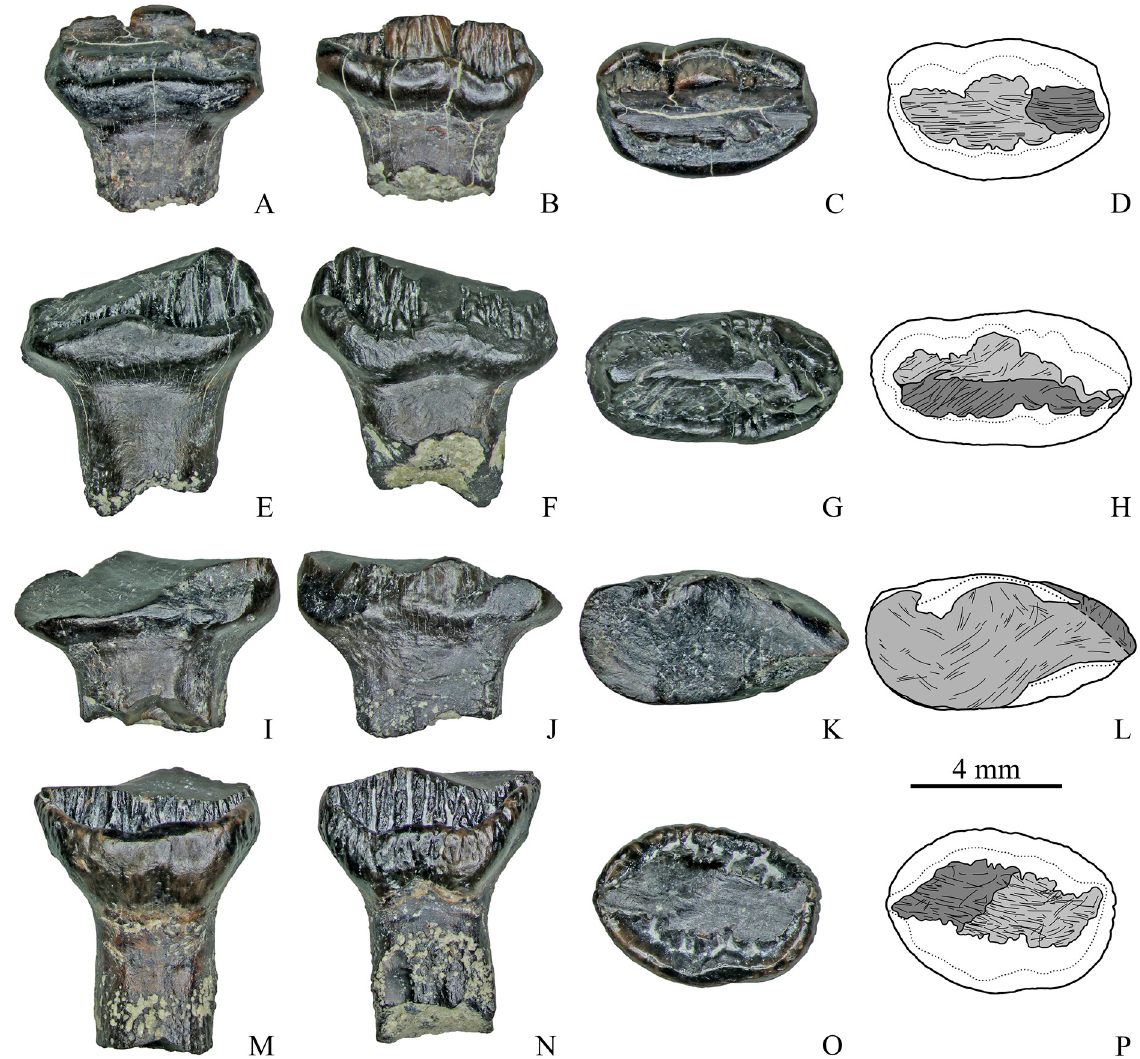
Fig 9. Dentary teeth with two wear facets of Stegosauria indet. from the Teete locality, Yakutia, Russia; Batylykh Formation (Lower Cretaceous). Specimens ZIN PH 12/246 (A-D), ZIN PH 21/246 (E-H), ZIN PH 25/246 (I-L), ZIN PH 49/246 (M-P) in labial (A, E, I, M), lingual (B, F, J, N), occlusal (C, G, K, O) views, and interpretive drawings in occlusal (D, H, L, P) view showing the wear facets with